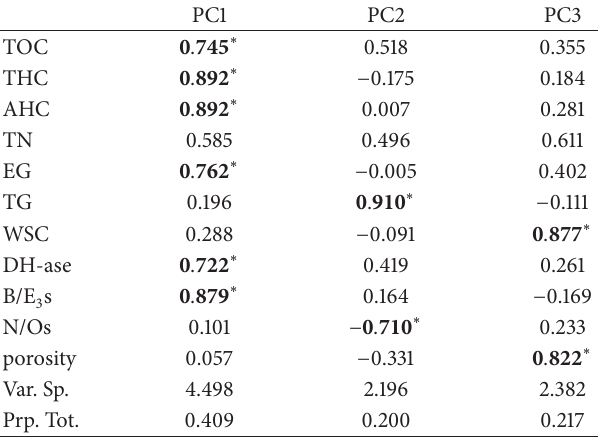
Table 4: Principal components (PC) and component loadings related to physical, chemical, and biochemical properties deter- mined in the different